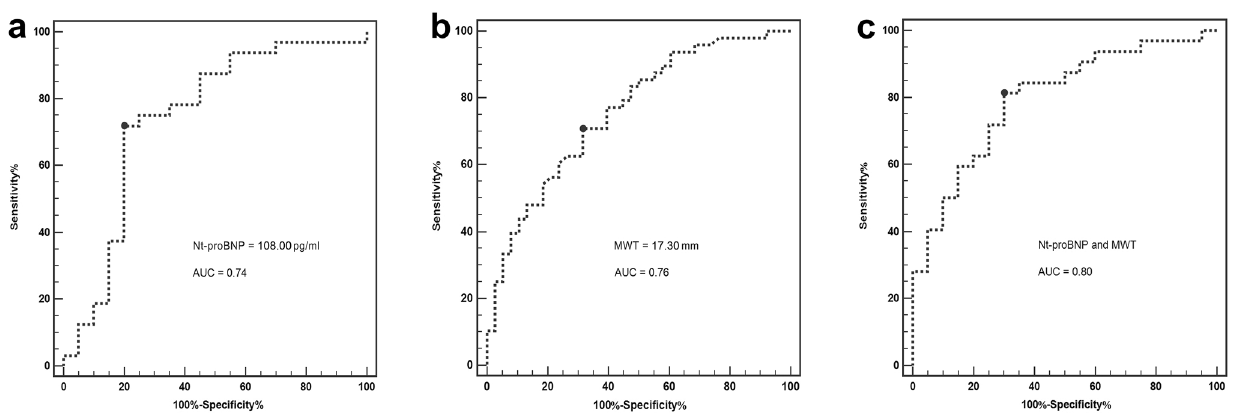
Figure 2. ROC curve analysis of the serum Nt-proBNP levels ( a ), MWT ( b ) and the serum Nt-proBNP level + MWT ( c ) for the identification of the presence of LGE in HCM patients. AUC area under curve, ROC receiver operating characteristic curve analysis, LGE late gadolinium enhancement, HCM hypertrophic cardiomyopathy, MWT Maximum wall thickness, Nt-proBNP N-terminal pro B-type natriuretic